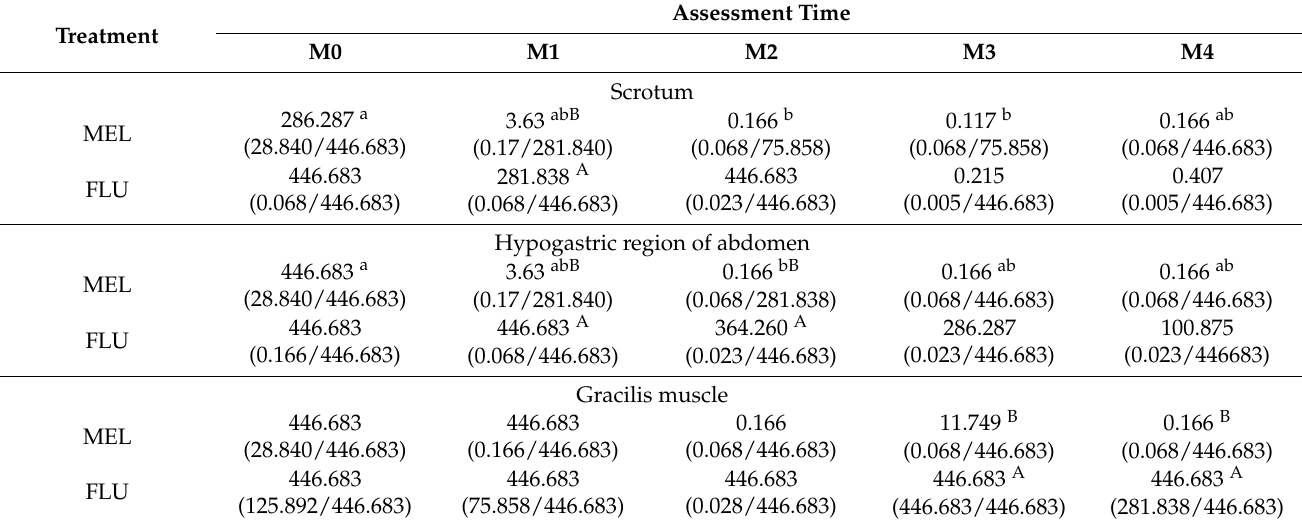
Table 1. Median, minimum, and maximum (min/max) force values (g) of the von Frey fila- ment test obtained in goat kids subjected to a surgical castration procedure under anesthesia and receiving analgesic protocols with meloxicam (MEL: 0.5 mg/kg − 1 IM) or flunixin meglumine (FLU: 1.1 mg/kg − 1 IM). Assessments were performed just before castration (M0), just after castration (M1), 1, 2, or 3 days after castration (M2, M3, and M4, respectively), in three body regions: scrotum (average of four points), hypogastric region of the abdomen, and gracilis